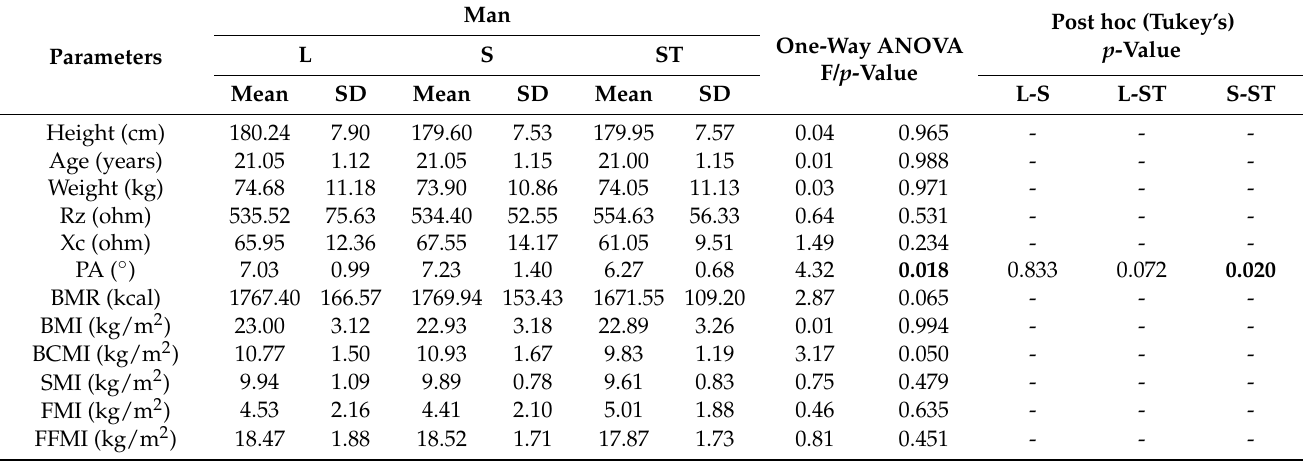
Table 1. Anthropometric and nutritional indicators among